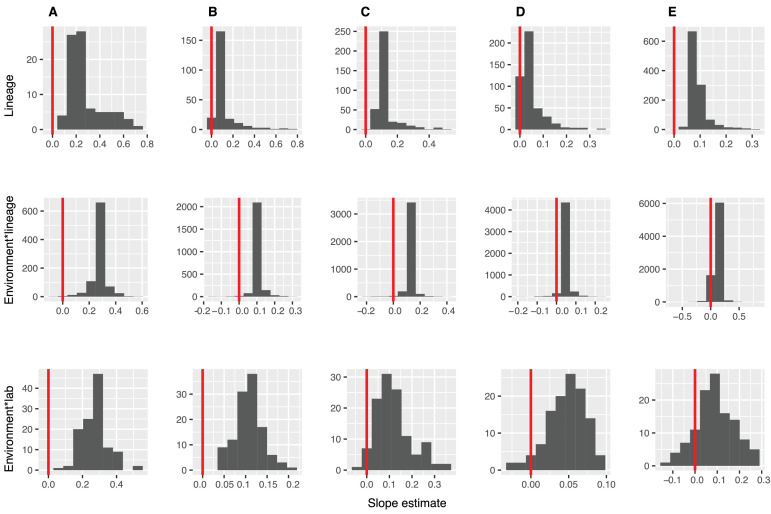
Distributions of diversity slope estimates across different random effects, from the GLMMs predicting focal lineage diversity as a function of community diversity.(A) Class:Phylum, (B) Order:Class, (C) Family:Order, (D) Genus:Family, and (E) ASV:Genus. Estimation of random effect coefficients from the GLMMs (Table S1), shows that the effect of diversity on focal lineage diversity (slope estimates) are generally positive but could be negative in some lineages or combinations of environment, lineage (Environment*Lineage), and the laboratory that submitted the dataset (Environment*Lab).Linear models are shown for the number of classes per phylum (y-axis) as a function of community diversity (number of non-focal phyla, x-axis) in each of the 17 environments (EMPO3 biomes). Only environments containing the focal lineage are shown. P-values are Bonferroni corrected for 17 tests. Significant (p<0.05) models are shown with red trend lines.